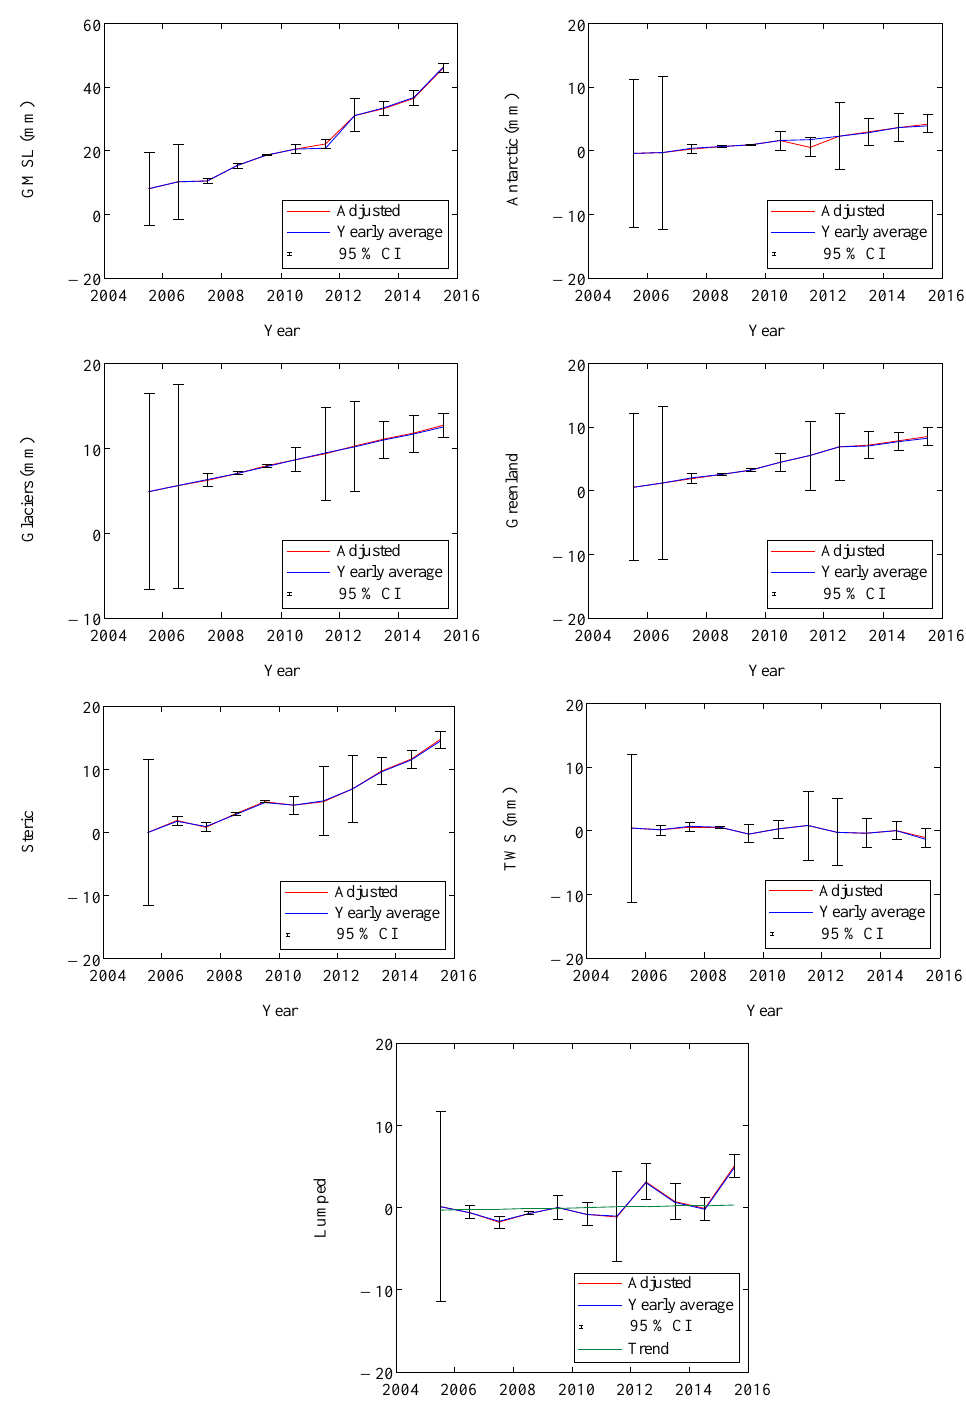
Fig. 4. Observed, adjusted and year by year closed GMSL budget